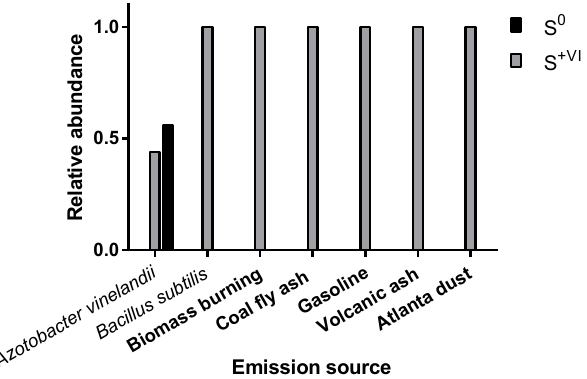
Figure 1. Oxidation state of sulfur in common emission sources. Common emission sources were generally dominated by S + VI (grey). Only the bacteria sample Azotobacter vinelandii showed a signal for S 0 as well as S + VI